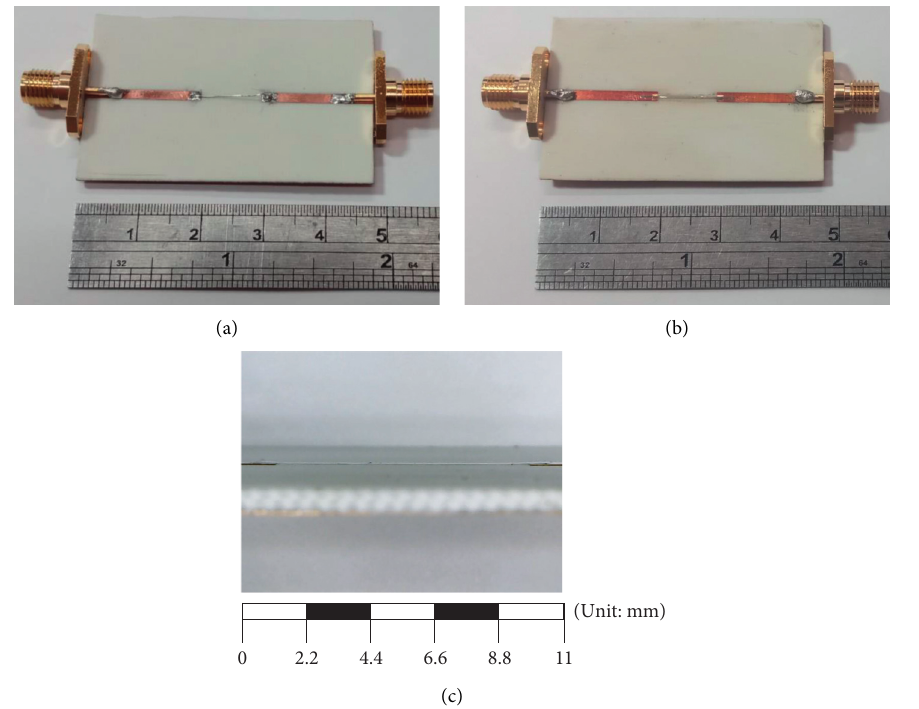
Figure 7: Interconnected bond wire fabricated using (a) the proposed fully inkjet-printing technique and (b) the conventional approach. (c) The close-up view of the fully inkjet-printed bond wire.